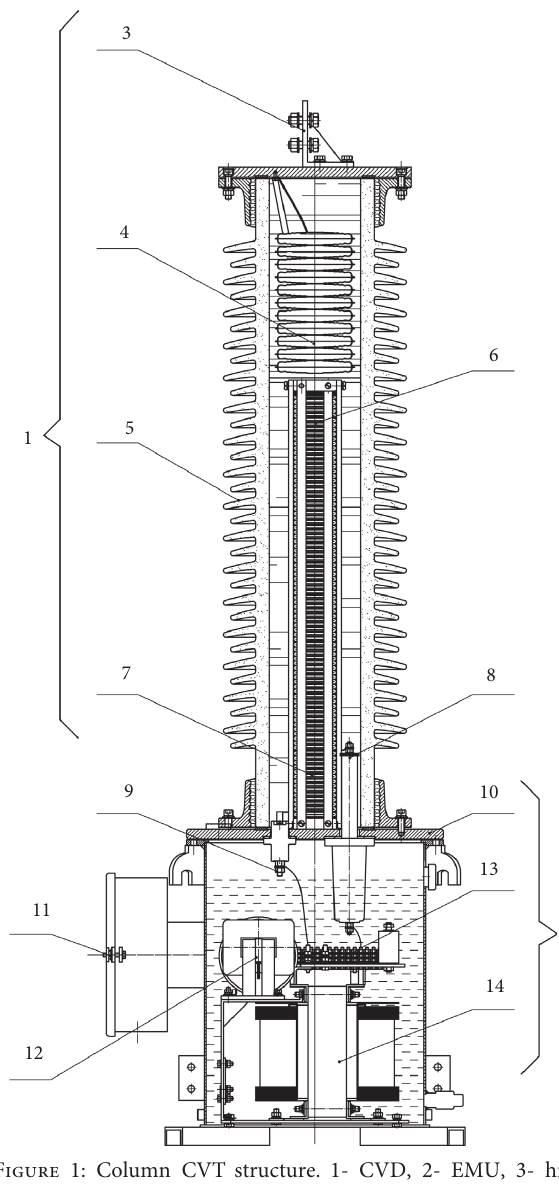
Figure 1: Column CVT structure. 1- CVD, 2- EMU, 3- high- voltage terminal, 4- metal expander, 5- porcelain insulator, 6- high- voltage capacitor, 7- medium-voltage capacitor, 8- medium-voltage tap, 9- low-voltage terminal, 10- EMU box, 11- secondary terminal box, 12- compensation reactor, 13- damper, and 14- medium- voltage